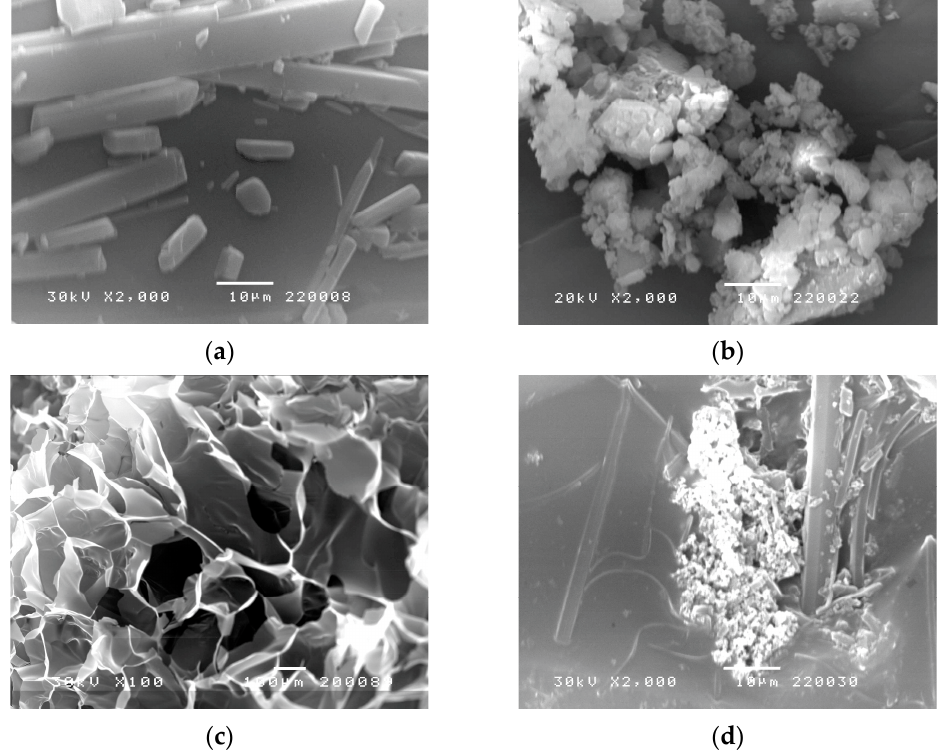
Figure 11. Scanning electron microscopy micrographs (SEM): ( a ) curcumin, ( b ) curcumin:2 ‐ hydrox ‐ ypropyl ‐β‐ cyclodextrin complex, ( c ) p(NiPMAm/NiPAm) hydrogel containing 2 mol% EGDM, ( d ) p(NiPMAm/NiPAm) hydrogel containing 2 mol% of crosslinker with incorporated curcumin:2 ‐ hy ‐ droxypropyl ‐β‐ cyclodextrin complex.